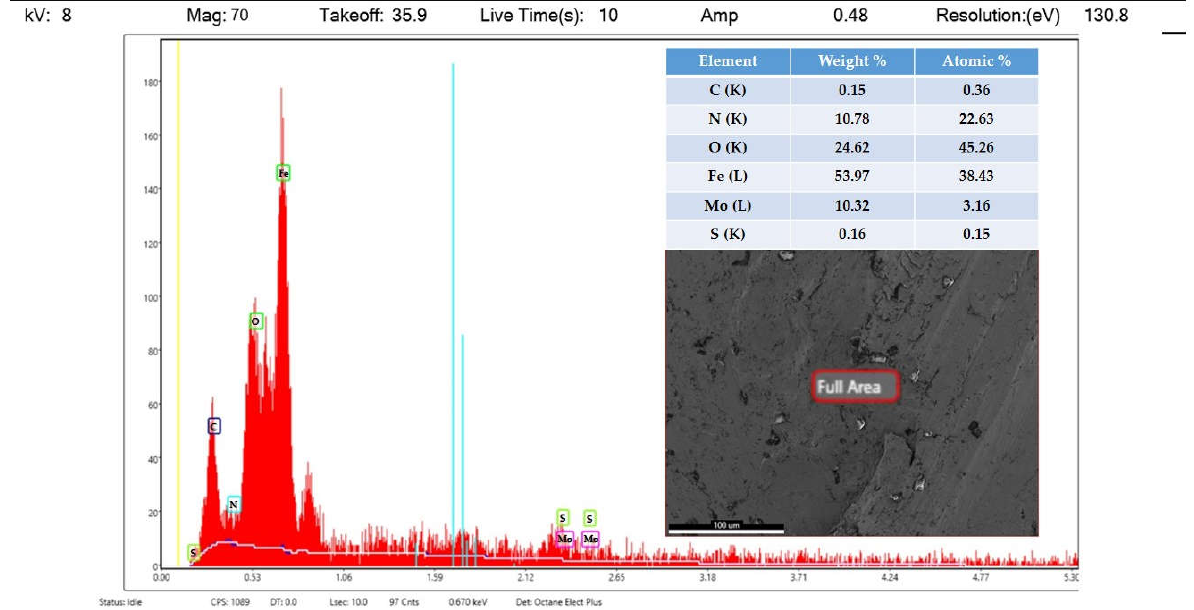
Figure 13. EDX elemental analysis of selected full area of pin surface used against g-C 3 N 4 /MoS 2 (9 wt.%) nanocomposite coated disc tested at 0.75 m/s sliding speed and 15 N applied load.